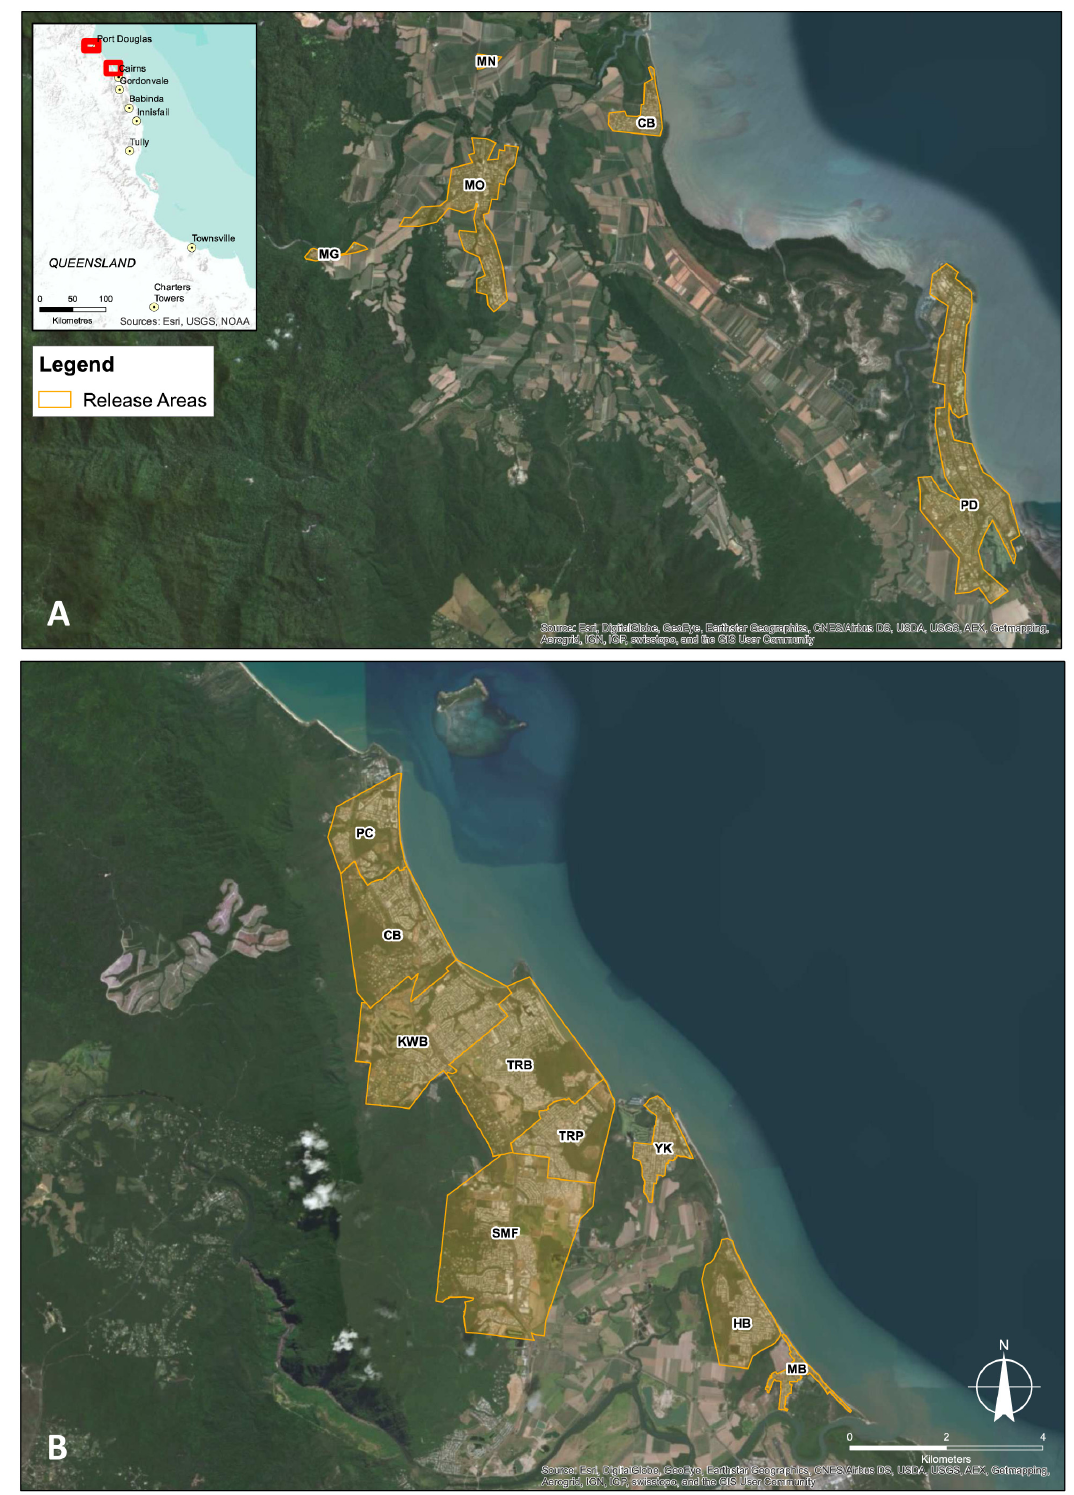
Figure 1. Map of Douglas release areas. Cooya Beach (CB), Mossman (MO), Mossman Gorge (MG), Mossman North (MN), Port Douglas (PD) ( A ) and Cairns (northern) release areas: Clifton Beach (CB), Holloways Beach (HB), Kewarra Beach (KWB), Machans Beach (MB), Palm Cove (PC), Trinity Beach (TRB), Trinity Park (TRP), Smithfield (SMF), Yorkeys Knob (YK) ( B ).